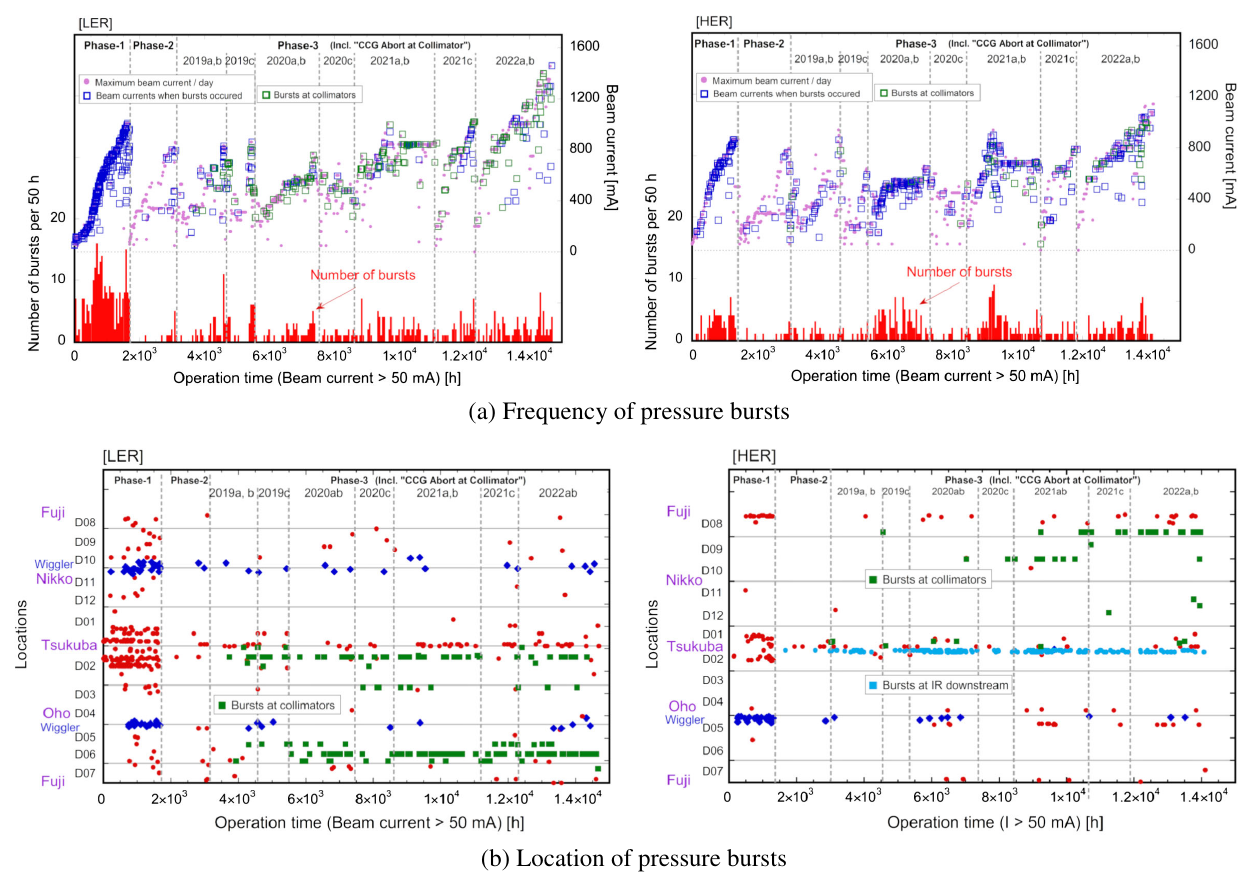
FIG. 24. (a) Number of bursts occurring per 50 h of operation time (red bars), the beam currents at which pressure bursts occurred (blue and green squares), I (pink dots), and (b) locations of the pressure bursts along the ring versus the operation time from 2016 for max the LER (left) and HER (right). Green solid squares and light-blue solid squares in (b) are the locations at beam collimators and at just downstream of IR,